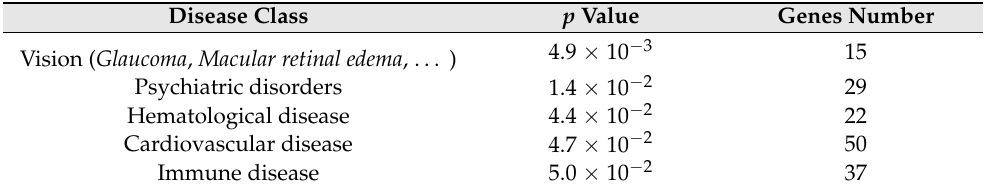
Table 1. Disease-based functional annotation enrichment results of core set genes. The table shows disease enrichment results for all diseases significantly enriched with an adjusted p -value < 0.05.